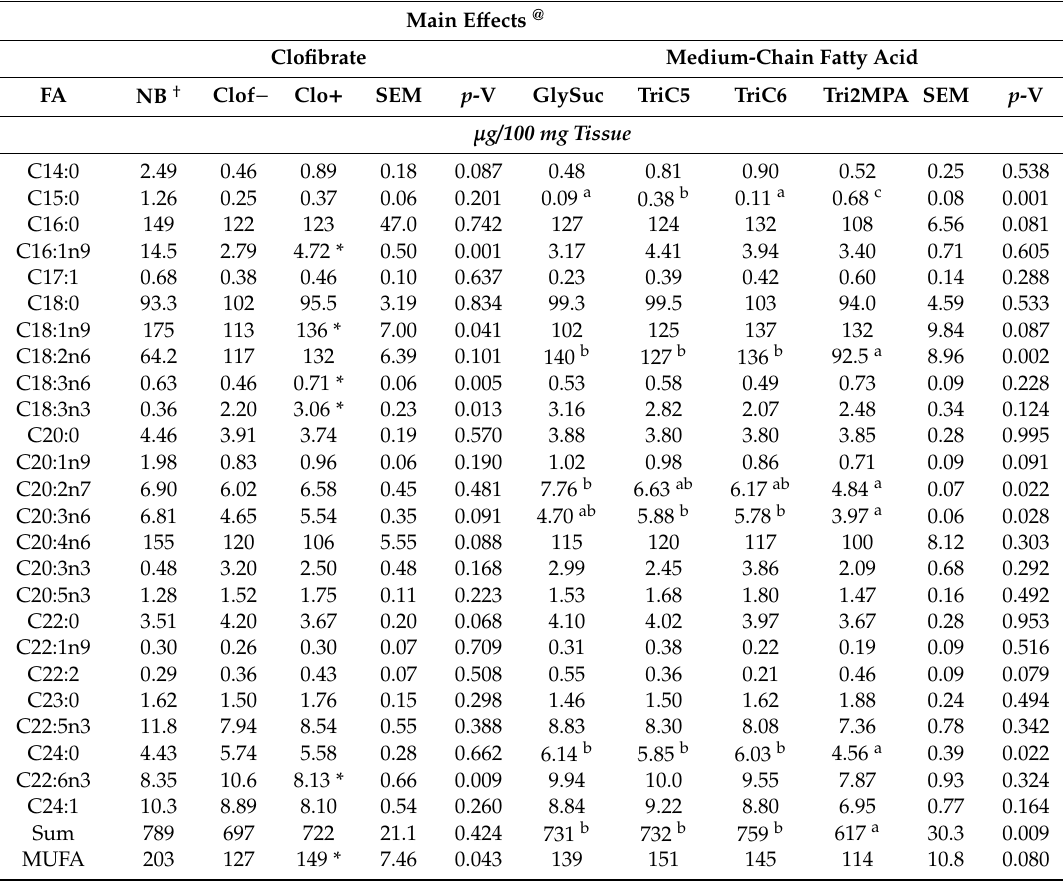
Table 1. E ff ect of clofibrate and medium-chain triglycerides on renal fatty acid